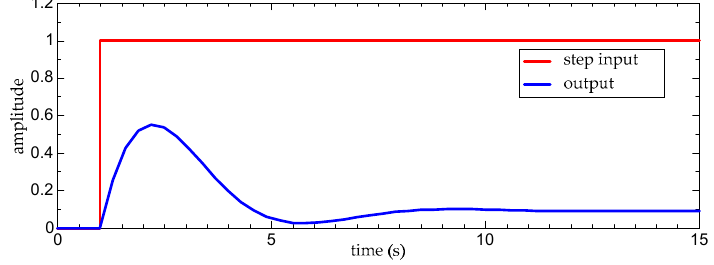
Figure 6. Step response of the neuron model.